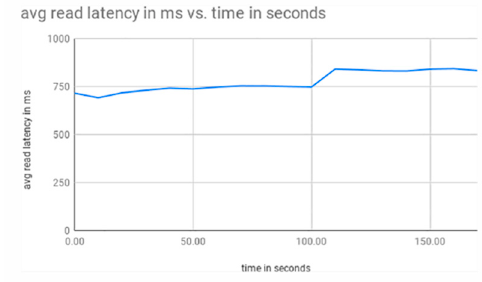
Figure 15. Writes latency curve versus the command operations count.